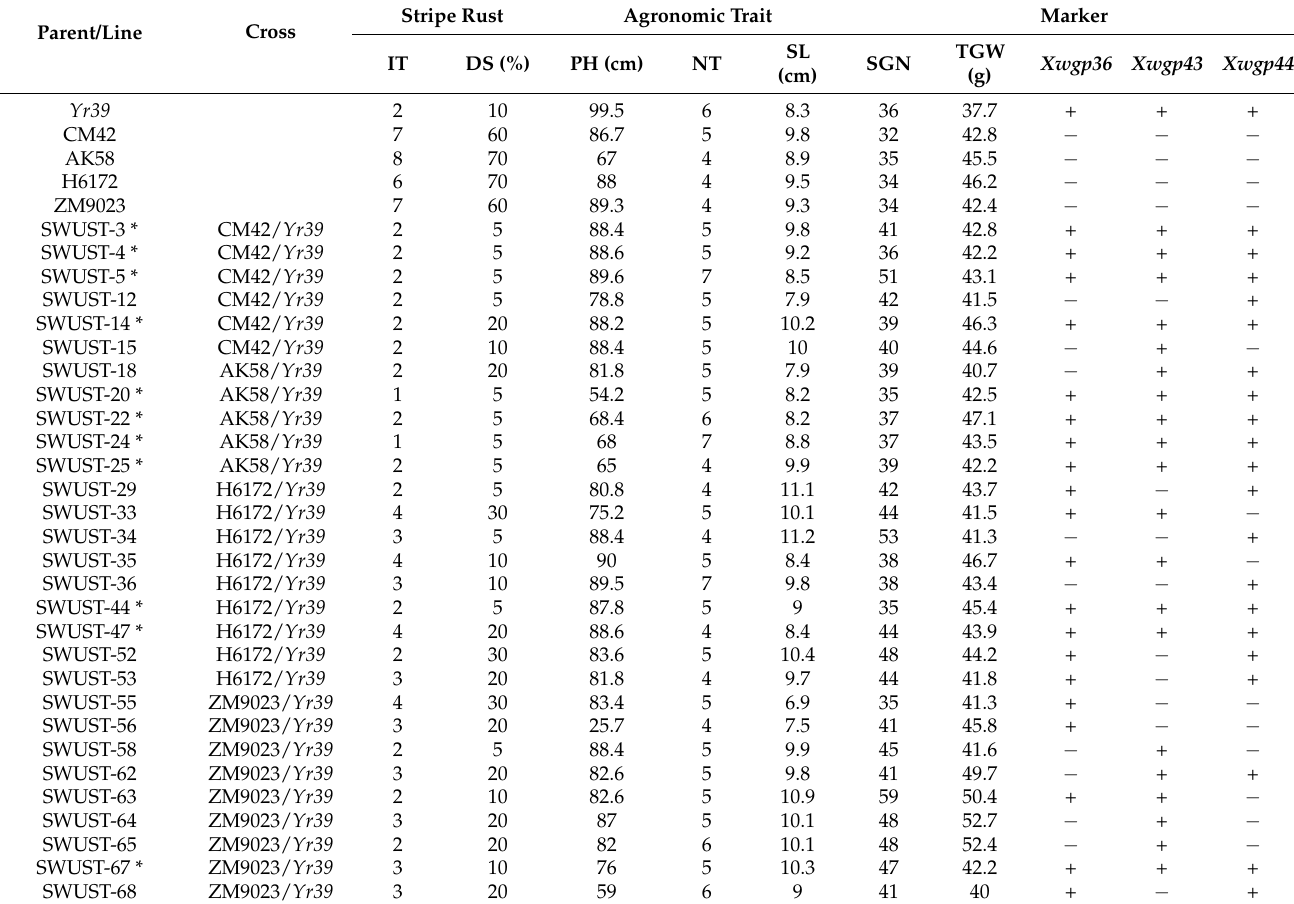
Table 4. Evaluation of resistance to stripe rust, agronomic traits, and molecular marker detection